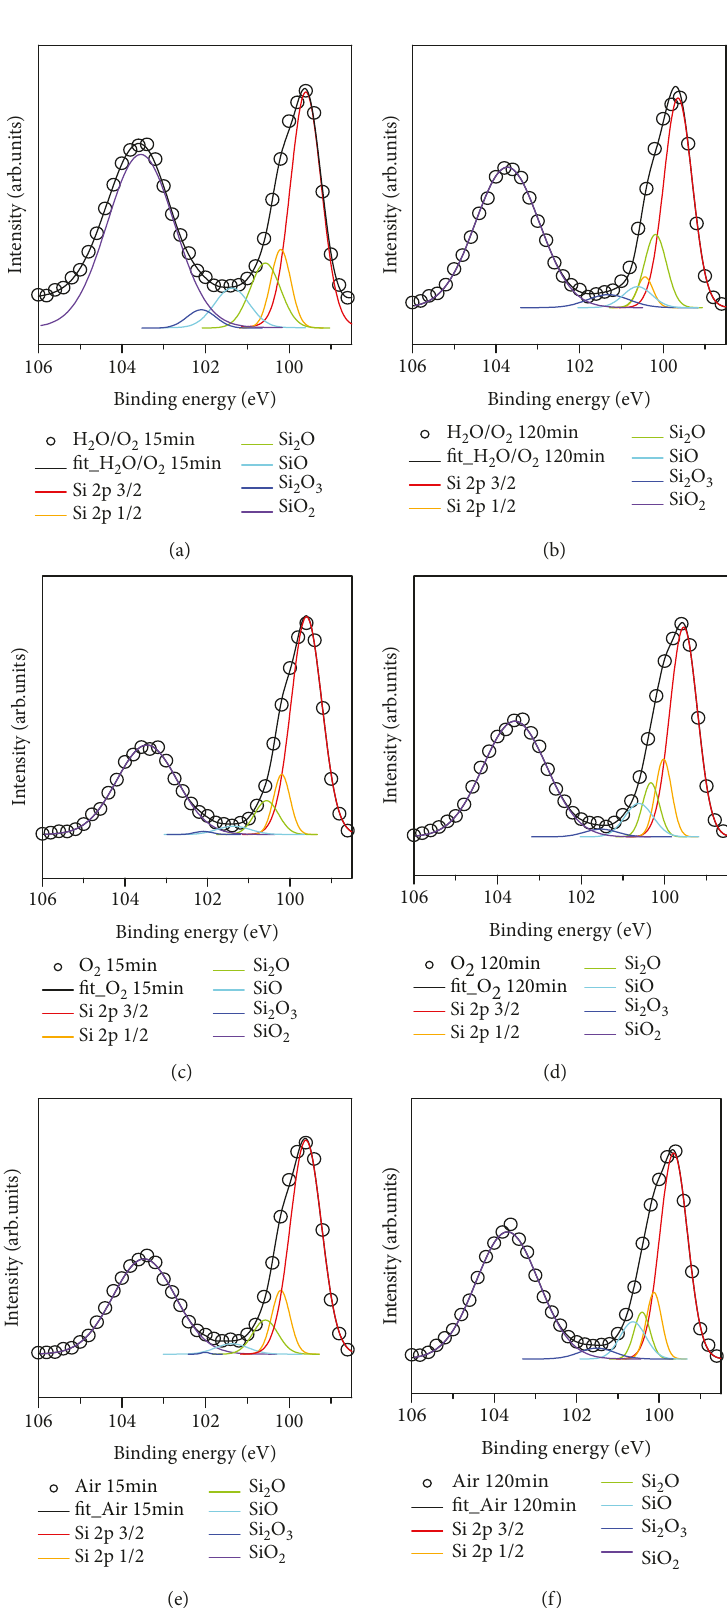
Figure 3: XPS Si 2p core level spectra with suboxides of Al-acac-based AlO 120min, (c) O